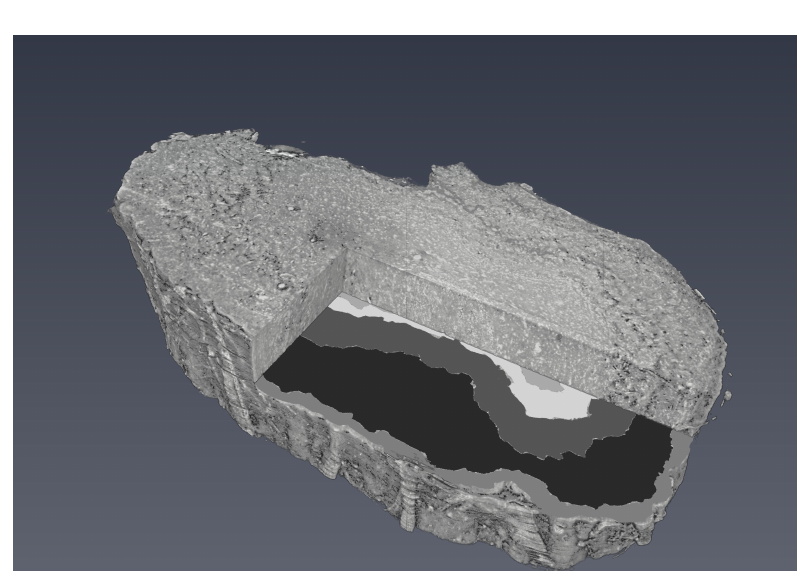
Figure 6. 3D visualisation of OB with segmented tomographic slice.